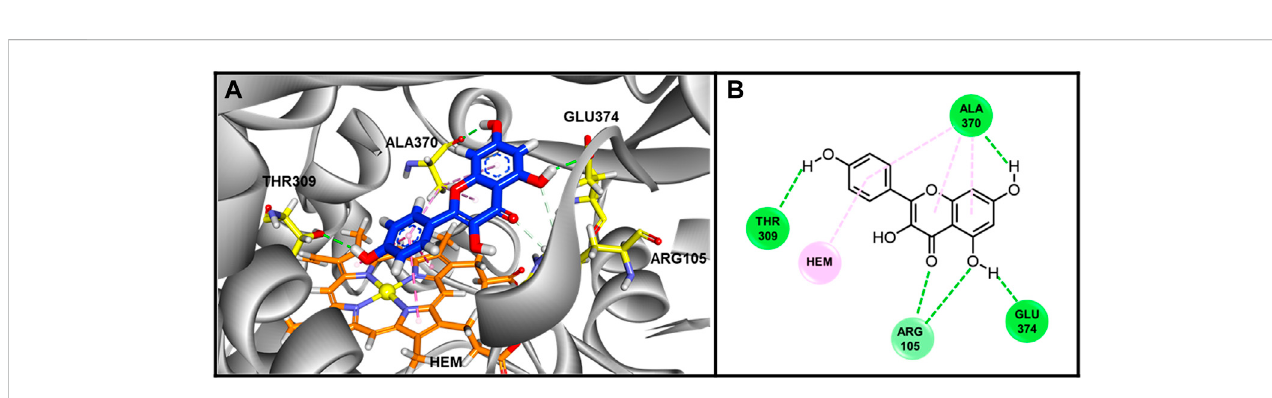
FIGURE 8 The Binding conformations of compound Kaempferol with enzyme CYP3A4. (A) 3D Binding pose of Kaempferol in inhibited binding domain of CYP450 3A4. For Kaempferol, carbon and oxygen are highlighted in blue and red, respectively. For amino acids of protein, carbon, oxygen and nitrogen are displayed by yellow, red and blue, respectively. For HEM molecule, the orange, blue and yellow color stand for carbon, nitrogen and iron ion. (B) Binding interactions betweenKaempferolwithresiduesofCYP4503A4.Thegreenandpinklinesstandforhydrogenbondsandhydrophobicinteractions.Thedockingscore was − 44.7332 kJ/md, showing good binding af fi nity between kaempferol and CYP3A4.